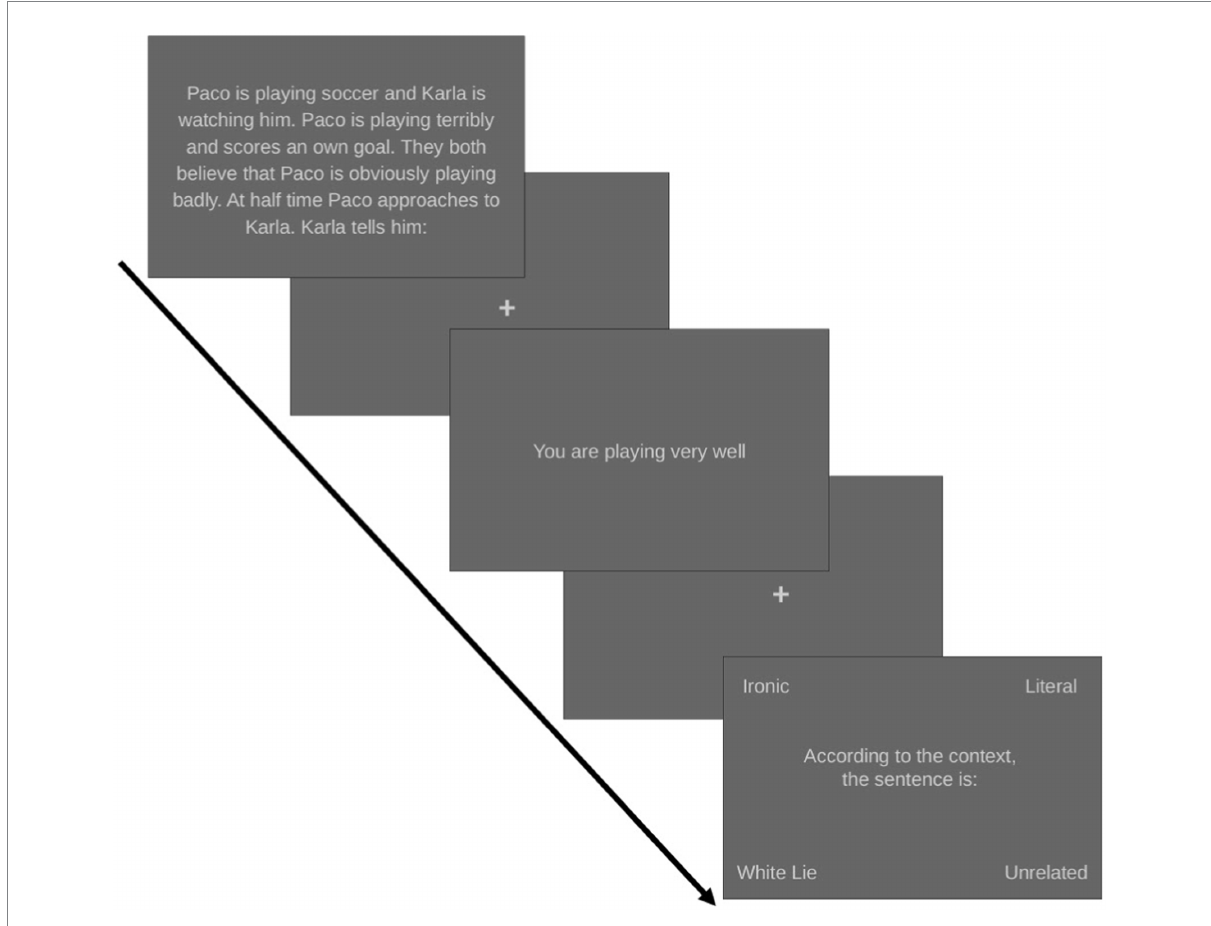
FIGURE 5 Contextual discrepancy task for Experiment 1, Contextual Discrepancy. The stimuli were presented in text